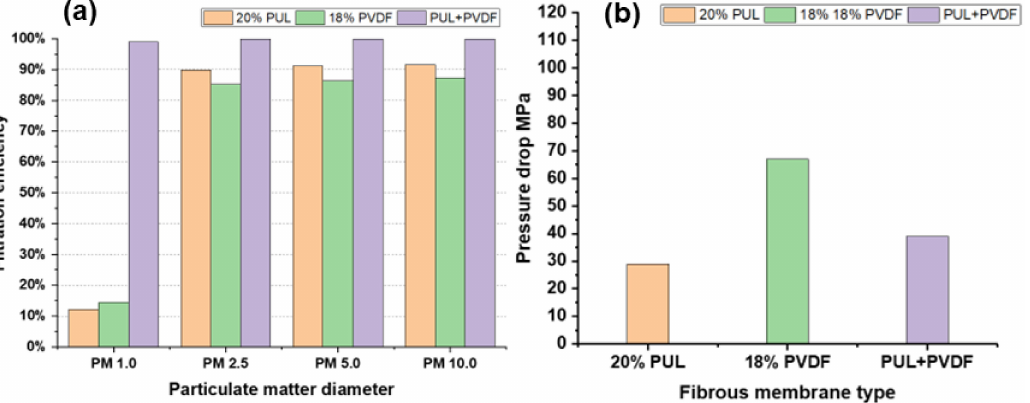
Figure 9. Particle filtration efficiency and pressure drop data of three types of nanofiber membranes. ( a ) Comparison diagram of filtration efficiency of three types of nanofiber membranes for different particles; ( b ) pressure drop comparison diagram of three types of nanofiber